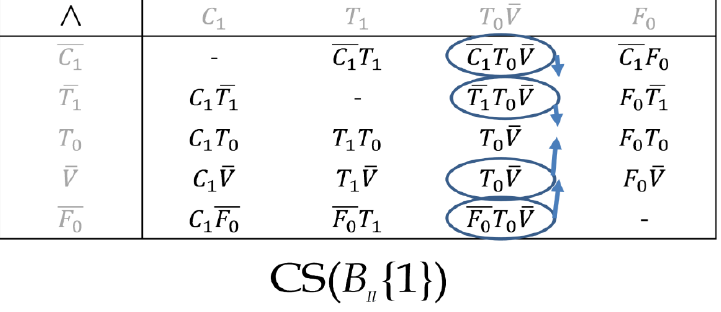
Fig. 16. Final multiplication to obtain all prime implicants of 𝑩 absorbed in a subsumed term. The terms 𝑪 and 𝑭 are sure to be included in CS( 𝑩